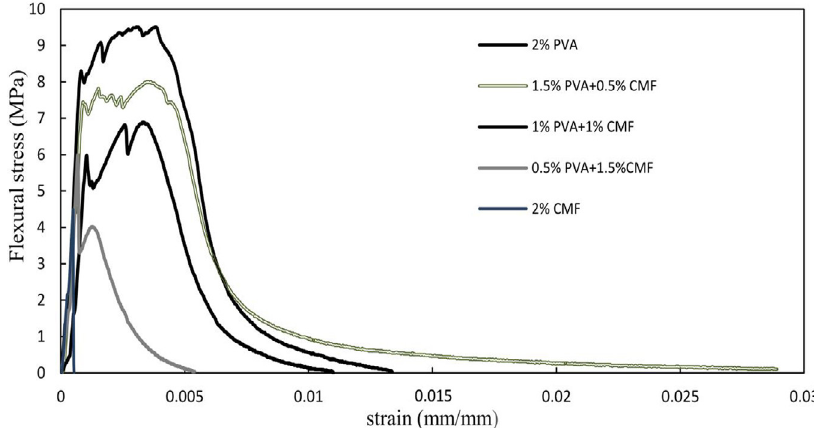
Fig. 10. Stress-strain curve of hybrid ECCs.